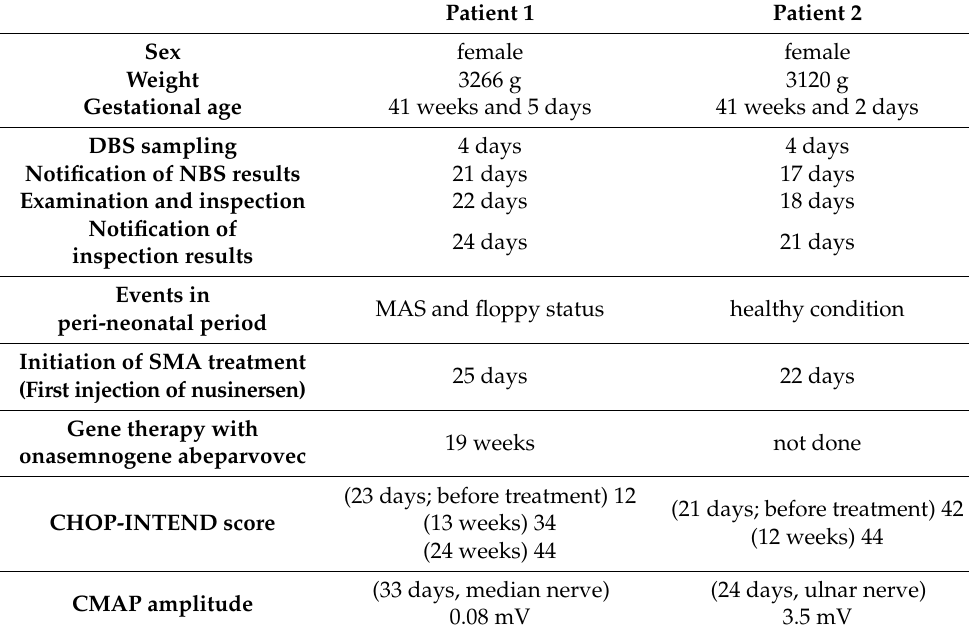
Table 4. Summary of the patients.